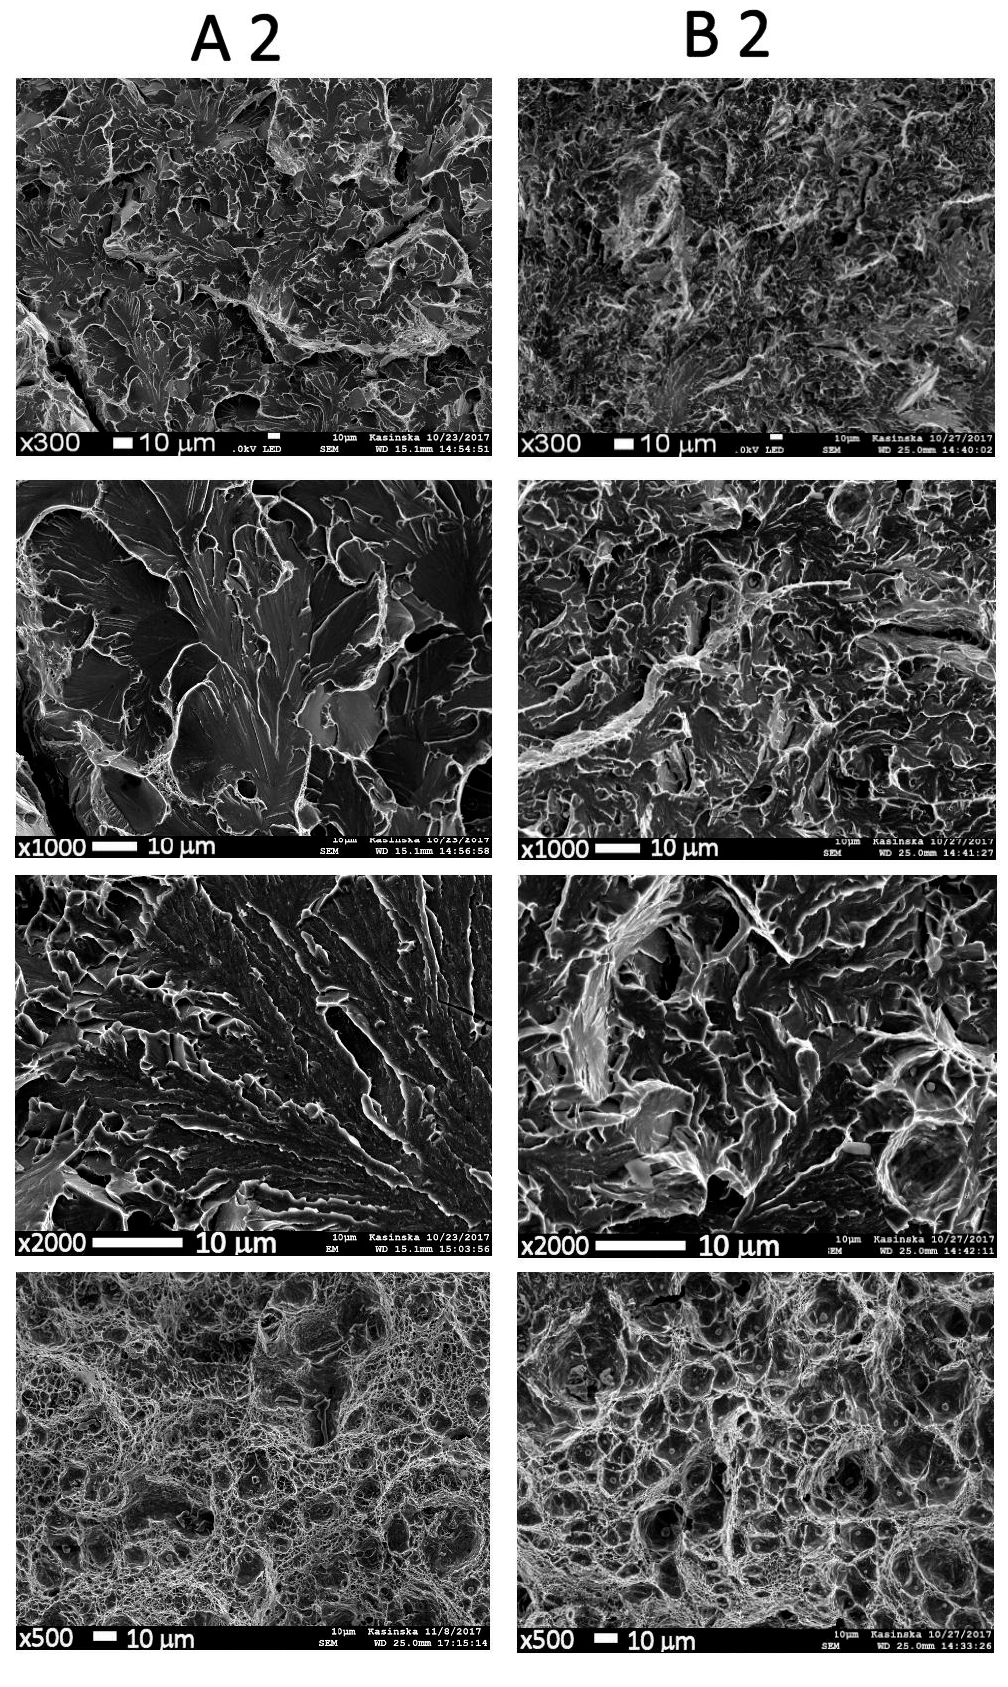
Figure 12. Morphology of A2 and B2 fracture surfaces.